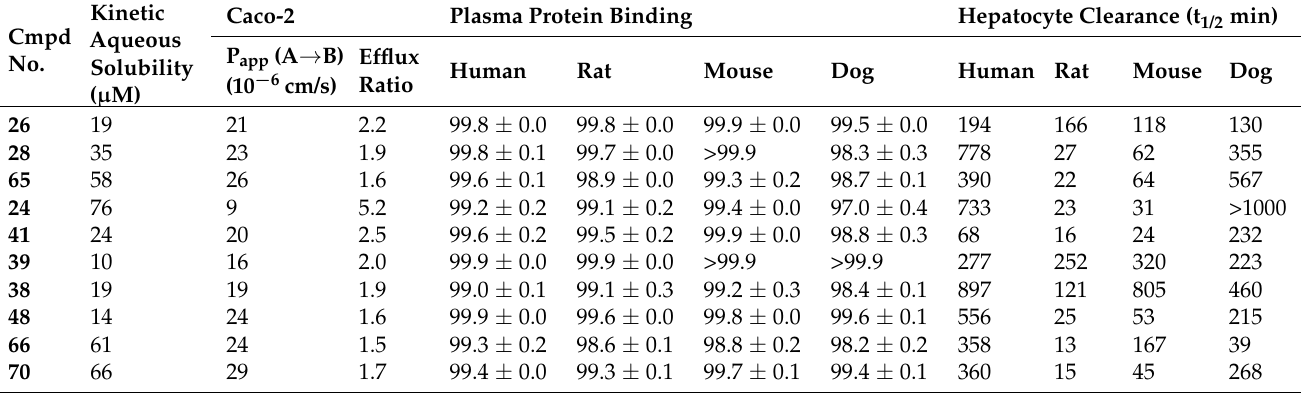
Table 4. Solubility, permeability, plasma protein binding and hepatocyte clearance properties of selected PERK